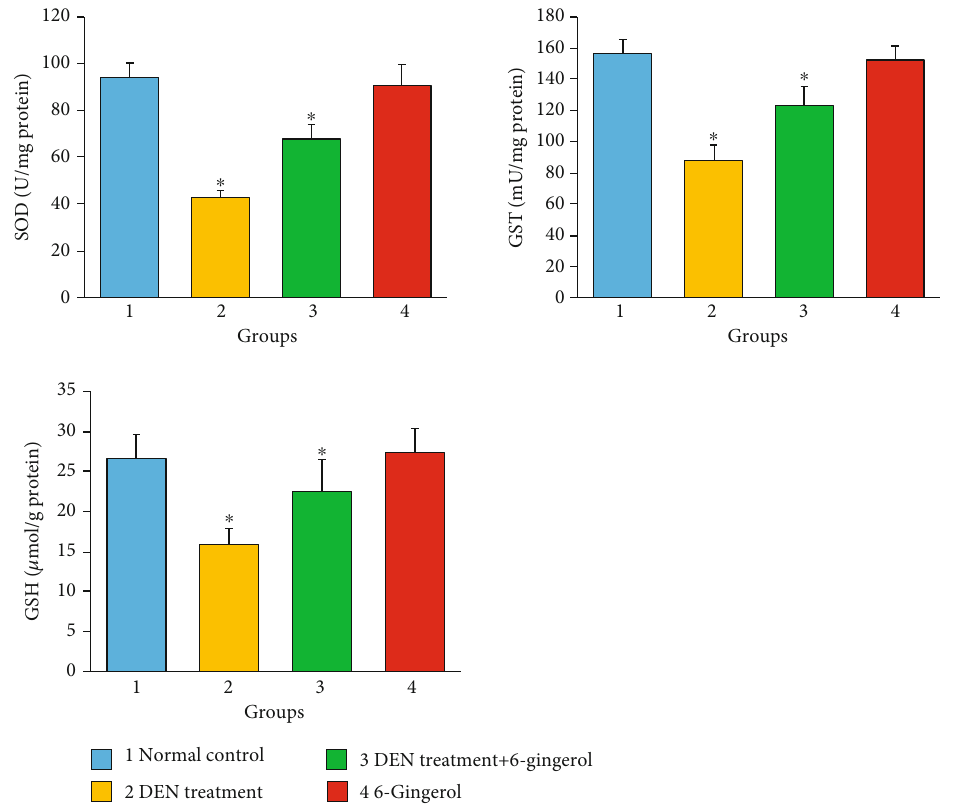
Figure 8: Glutathione (GSH), superoxide dismutase (SOD), and glutathione-S-transferase (GST) level in the di ff erent treatment groups. DEN-treated groups showed a decreased level of GSH, SOD, and GST enzymes as compared to the control group ( p < 0 : 05 ). Treatment of 6-gingerol and DEN increased the levels of these enzymes considerably as compared to the DEN-treated group ( p < 0 : 05 ).